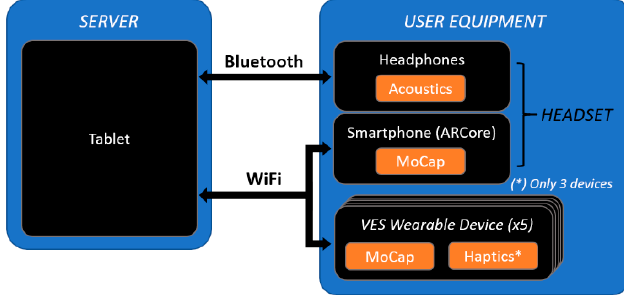
Figure 5. System architecture used in the tests.